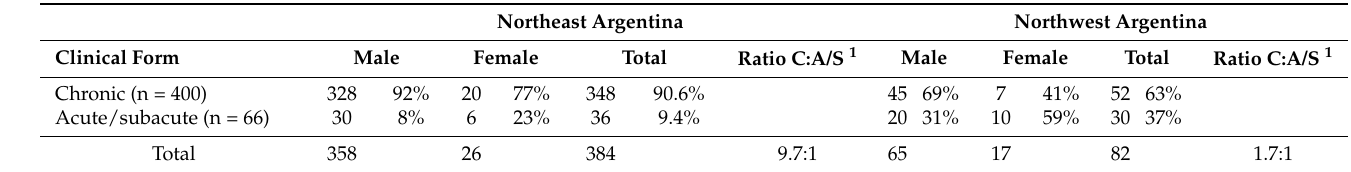
Table 3. Clinical forms and sex distribution in northeast (NEA) and northwest (NWA) Argen- tinian